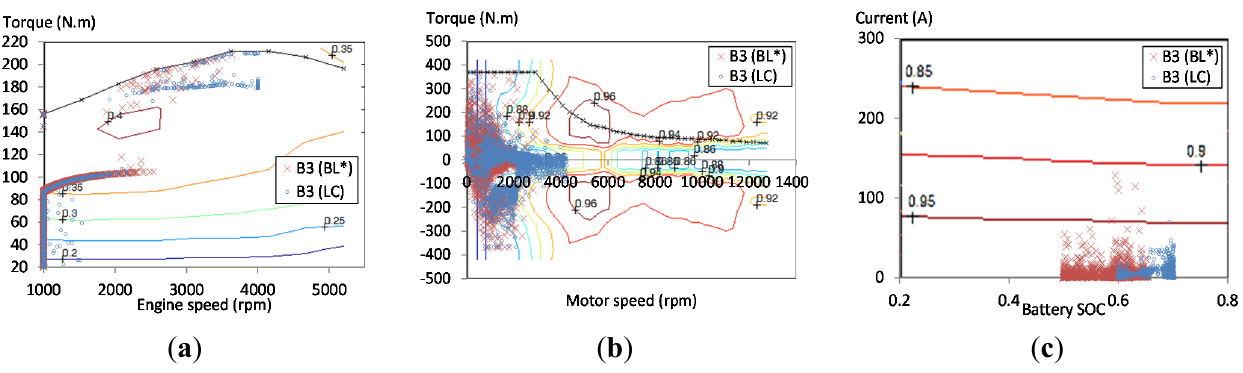
Figure A3. Plots of B3 solution engine ( a ), electric motor ( b ), and battery ( c ) operation for BL and LC driving cycles. (* driving cycle used in the